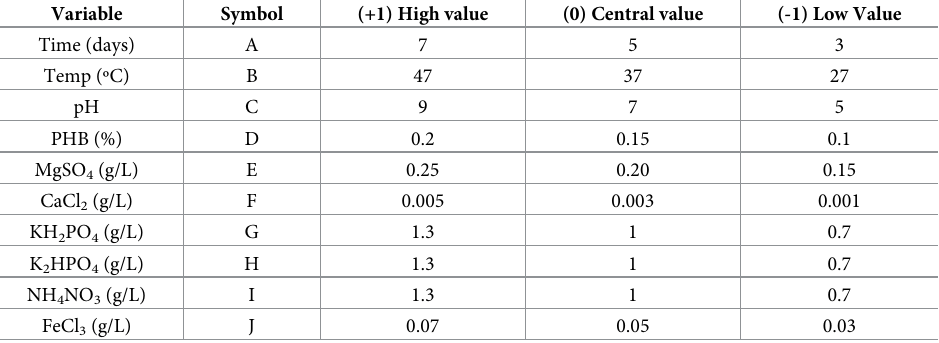
Table 6. Component design of Plackett Burman for PHB depolymerase production with the bacterial strain Aero- monas caviae Kuk1-(34) sp.